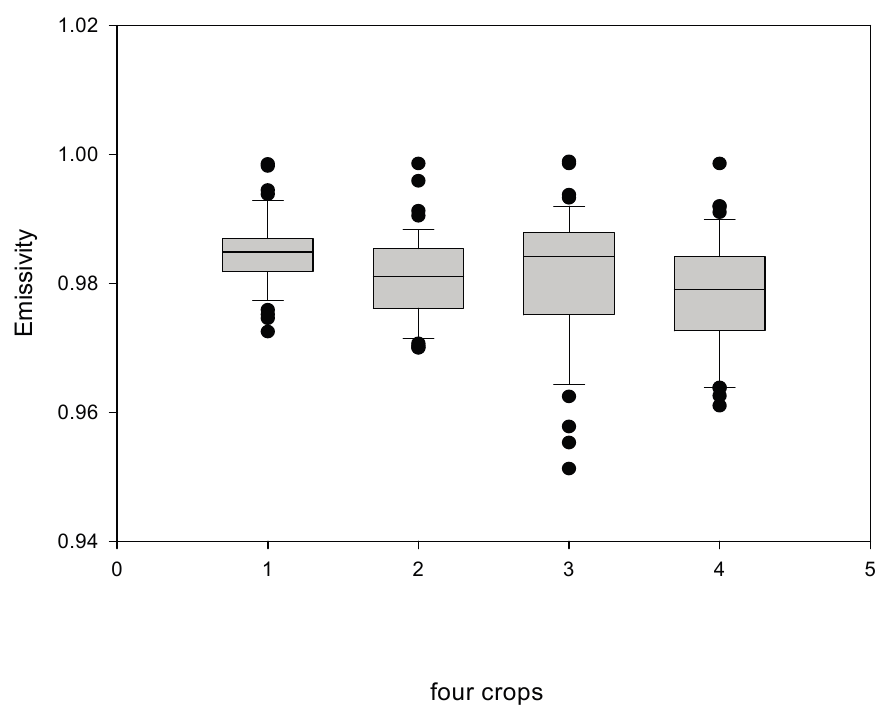
Figure 5. Statistical analysis of emissivity data: 1. Malabar chestnut; 2. Paphiopedilum ; 3. Phalaenopsis mature; 4. Phalaenopsis new